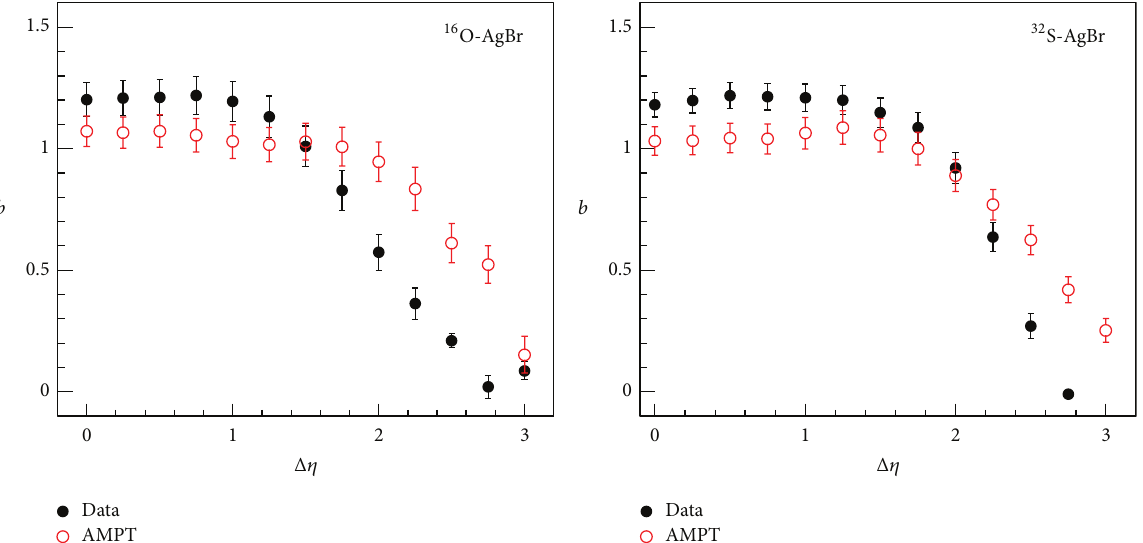
Figure 3: Variations of correlation strength 𝑏 with pseudorapidity window width, Δ𝜂 for 16 O- and 32 S-AgBr